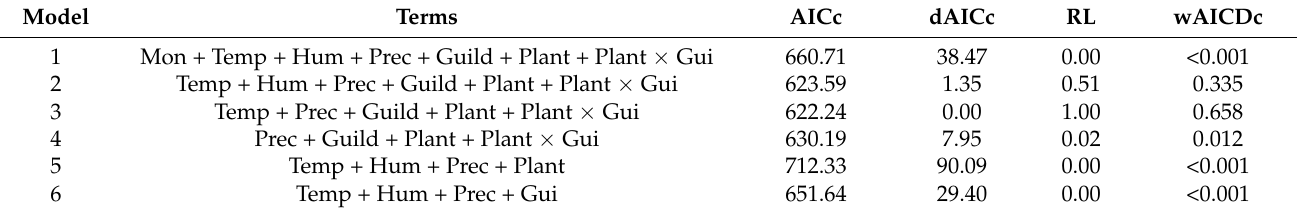
Table 1. List of candidates generalised linear models showing the link between bat abundance to seasonal changes in climate (temperature (Temp), humidity (Hum), and precipitation (Prec)), plantation type (Plant), and guild (Gui). Model Terms AICc dAICc RL wAICDc